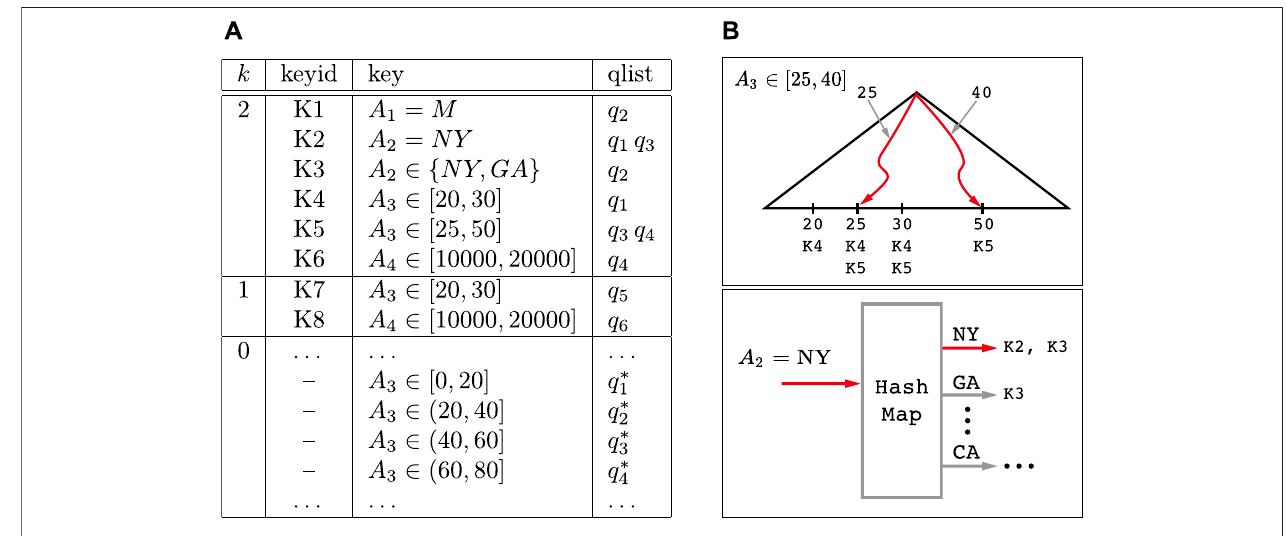
FIGURE 5 | Index structures for the range